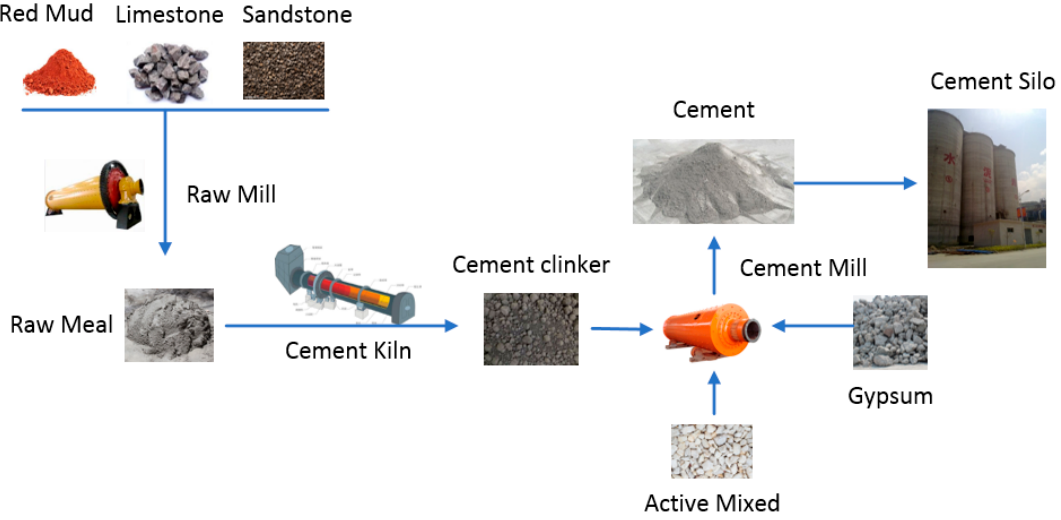
Figure 4. Preparation process of RM-based Portland cement.